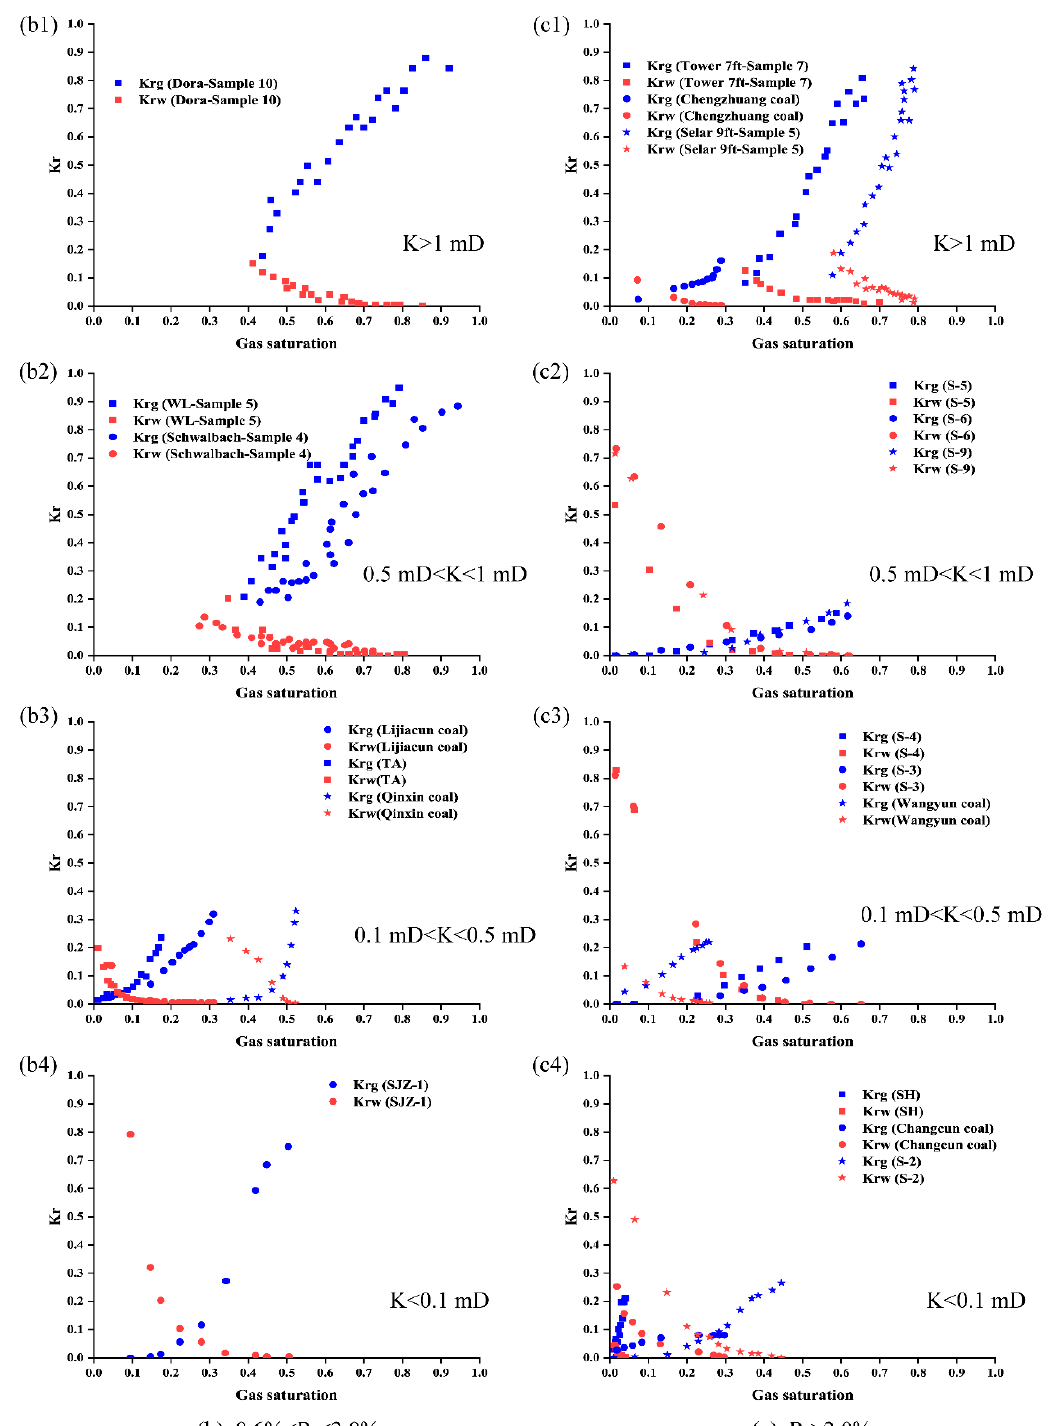
Figure 10. Summary of the relative permeability results according to the permeability and coal rank.